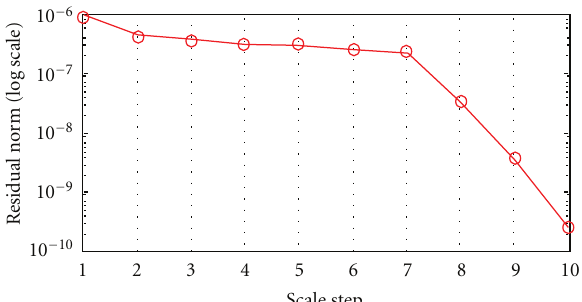
Figure 6: Algorithm I. Behavior of the relative residual (cid:12) r i (cid:12) 2 / (cid:12) r 0 (cid:12) 2 versus 10 scale steps. Δ τ I = 0 . 04.